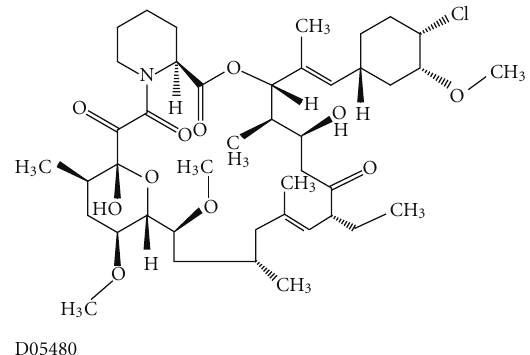
Figure 1: Molecular structure of pimecrolimus extracted from Kyoto Encyclopedia of Genes and Genomes (KEGG) database